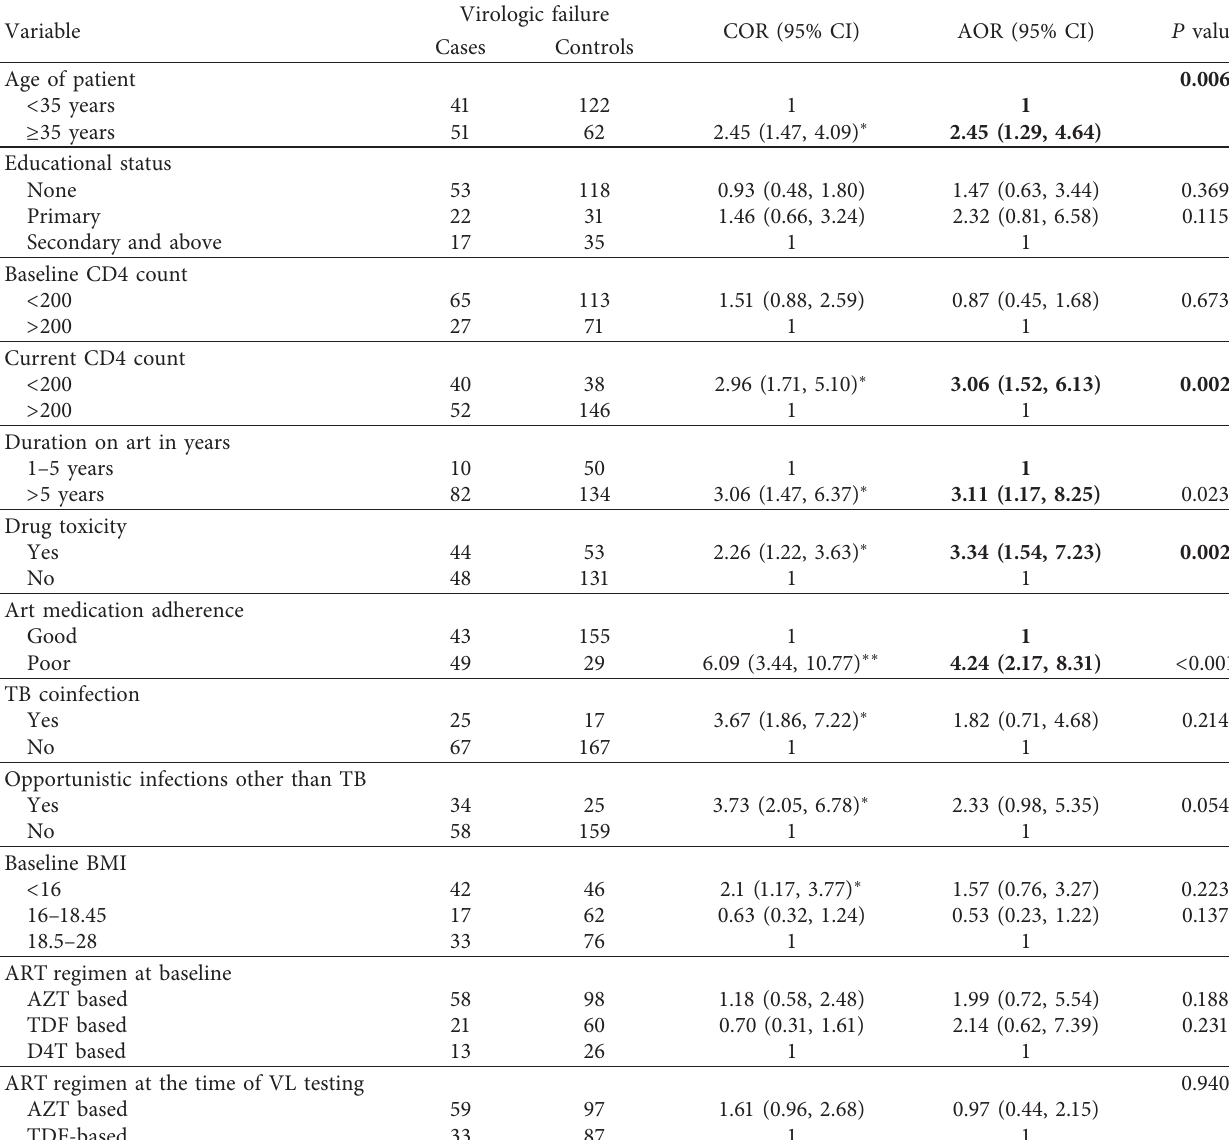
Table 5: Determinant factors of virologic failure among adult PLHIV attending ARTclinic at Waghimra zone health institutions, Northern Ethiopia, in 2019( n �